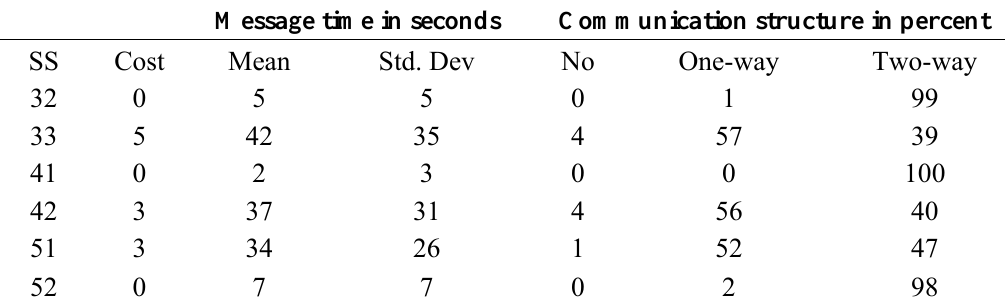
Table 2. Summary of message